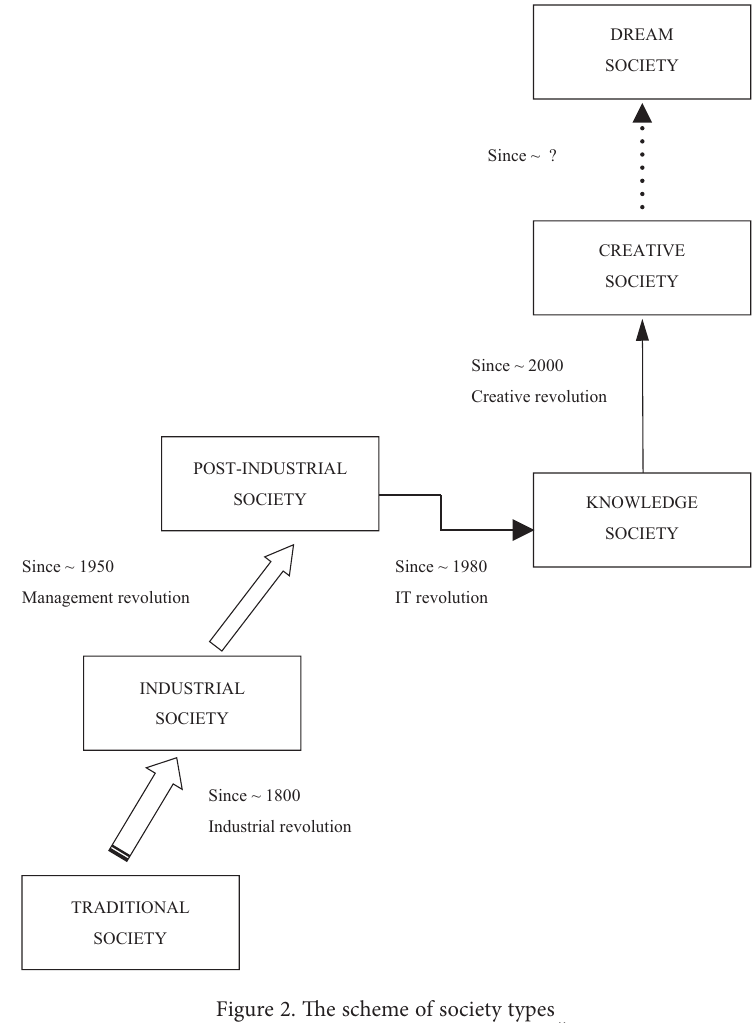
Figure 2. The scheme of society types (source: created by author, according to Remeika & Čepaitis,